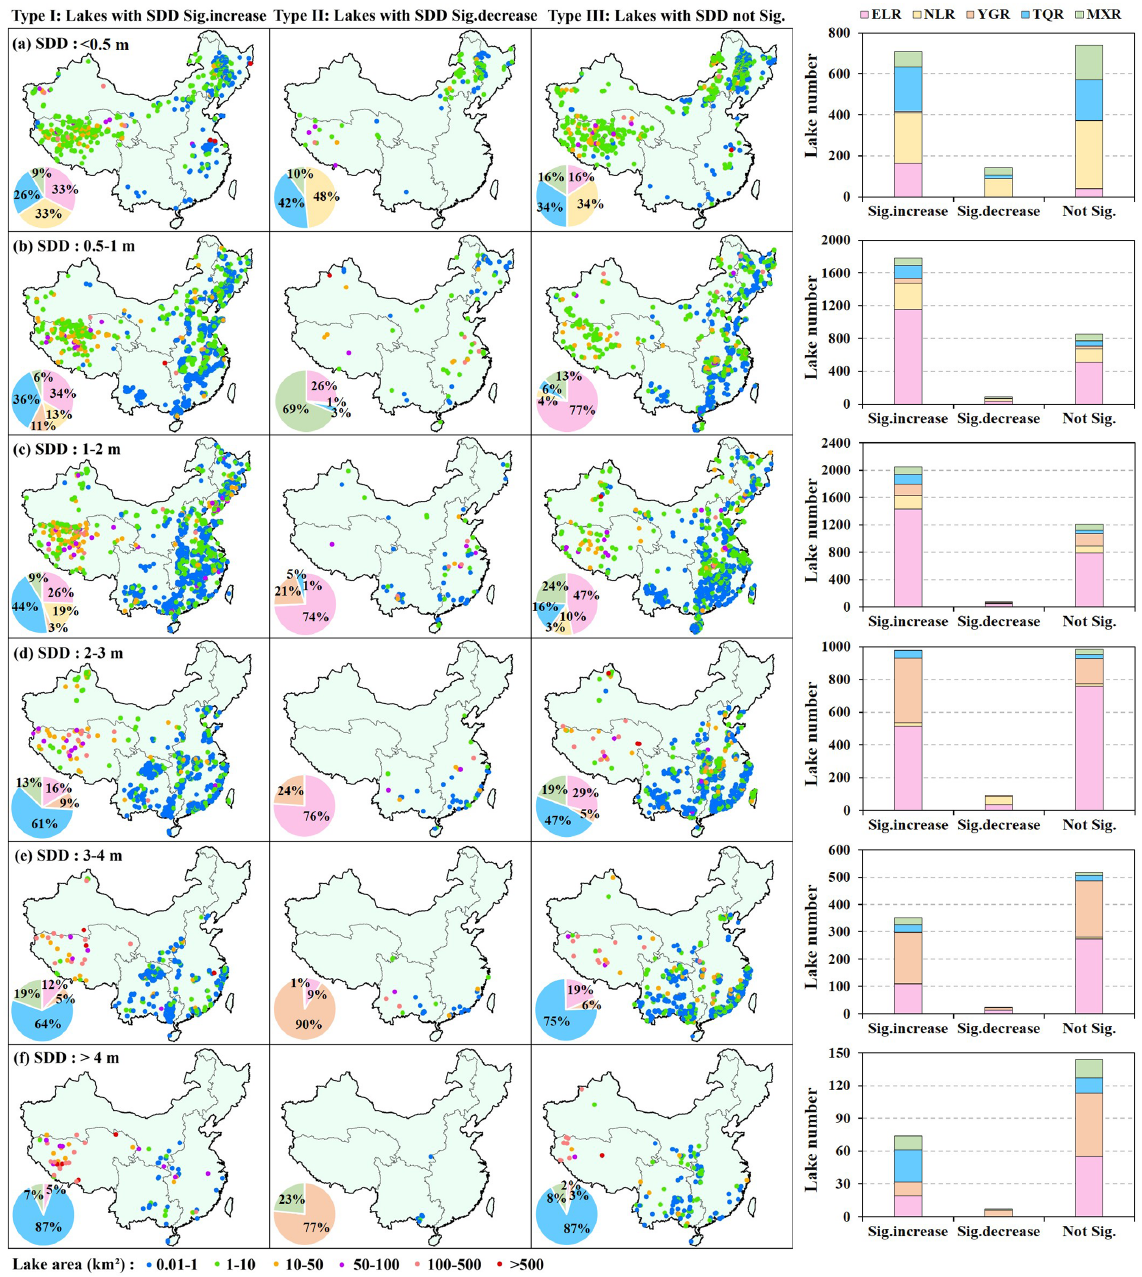
Figure 7. Spatial distribution of lakes with multi-year average SDD values during 1984–2018. The SDD values were divided into six levels: (a) < 0 . 5m, (b) 0.5–1m, (c) 1–2m, (d) 2–3m, (e) 3–4m and (f) > 4m. The lakes were separated into three types of lake – lakes with SDD showing significant increasing (Type I), significant decreasing (Type II) and non-significant (Type III) trends during 1984–2018. Proportions of total lake area and lake number in each lake region are shown in the pie charts and histograms,